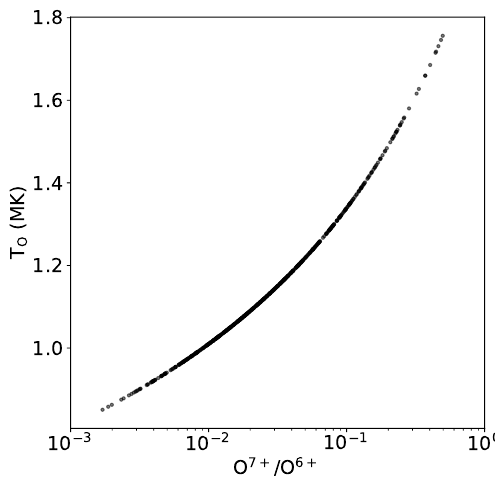
Figure 1. Plot of oxygen freeze-in temperature T O against the cor- responding oxygen charge state ratio O 7 + / O 6 + , from which it is calculated, taken from SWICS during the year 2007. Note that O 7 + / O 6 + is plotted on a logarithmic scale, demonstrating that lin- ear variations in T O correspond to order-of-magnitude variations in O 7 + / O 6 +